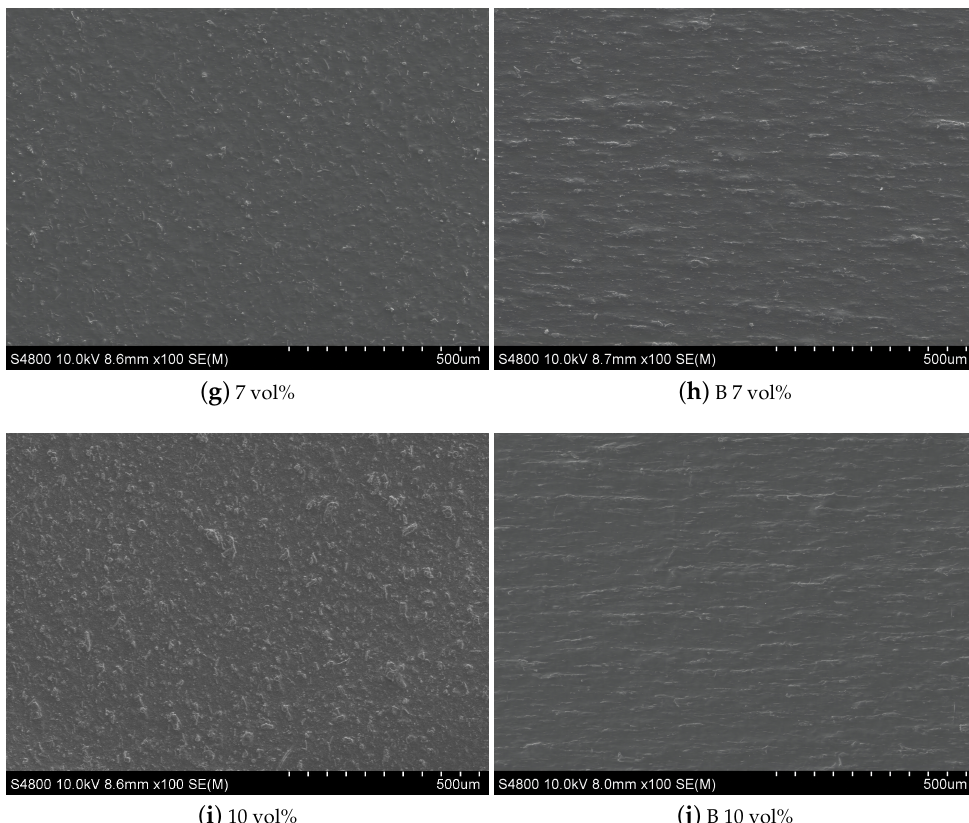
Figure 6. SEM images of 7FO/PVDF nanocomposite films with different doping ratios.